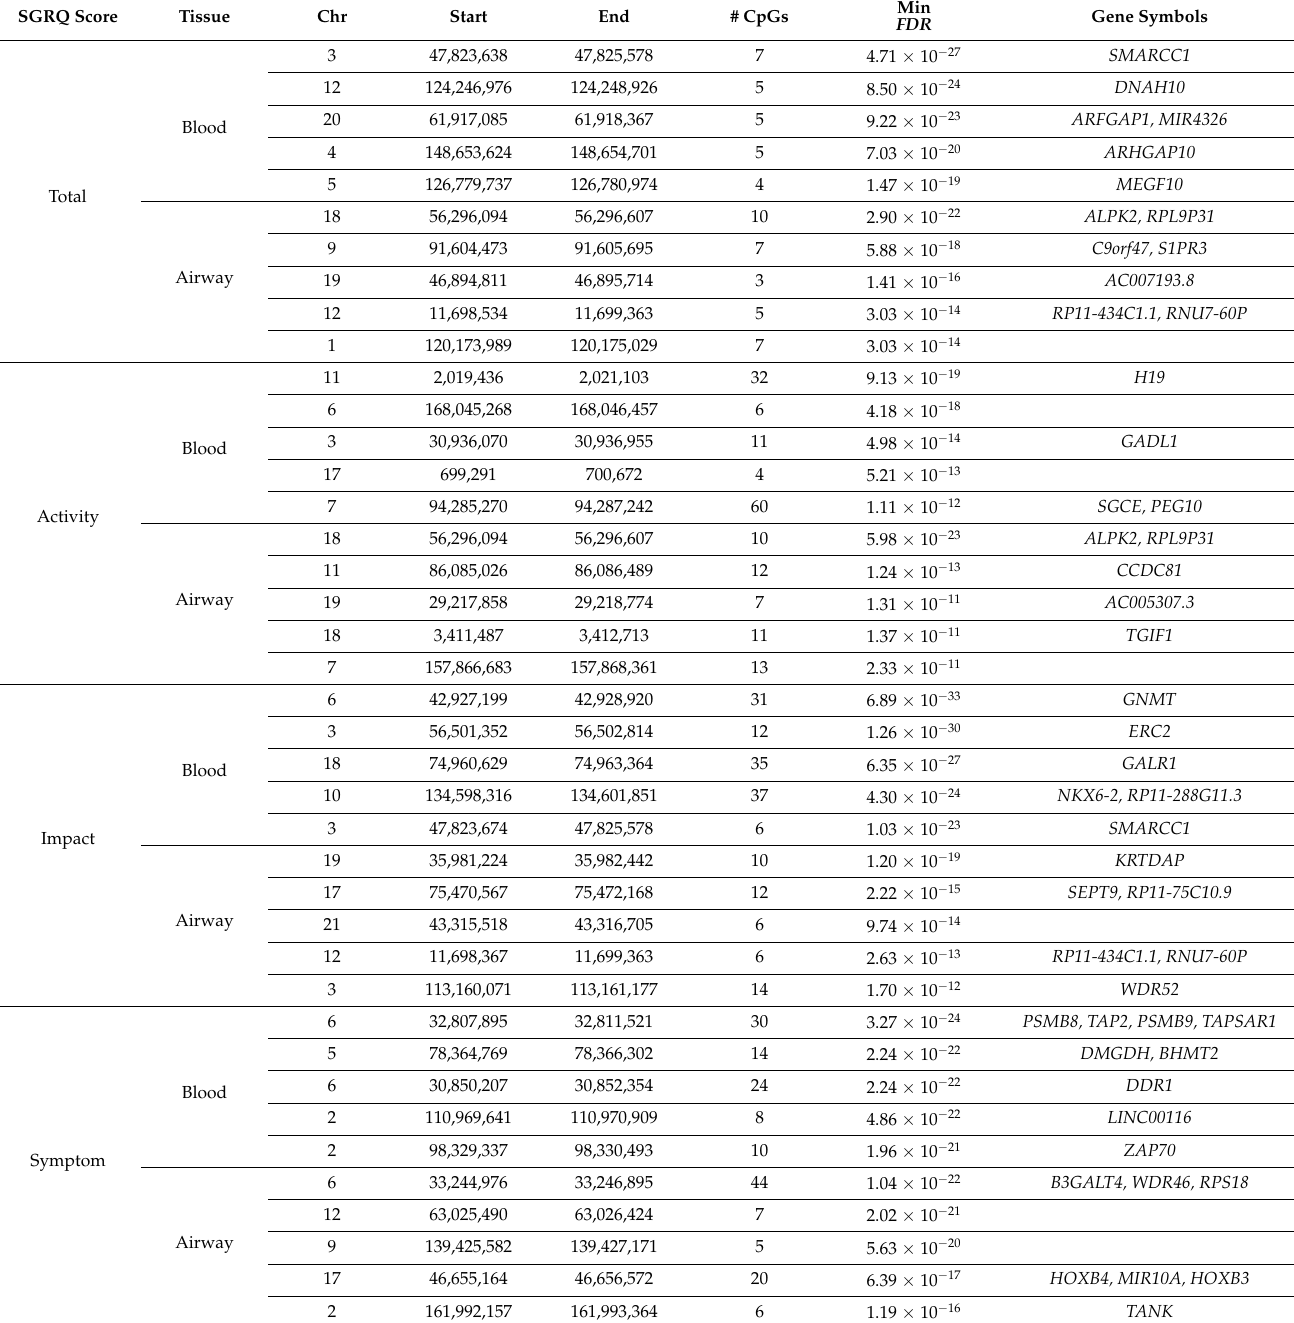
Table 3. Top five blood and airway DMRs for SGRQ